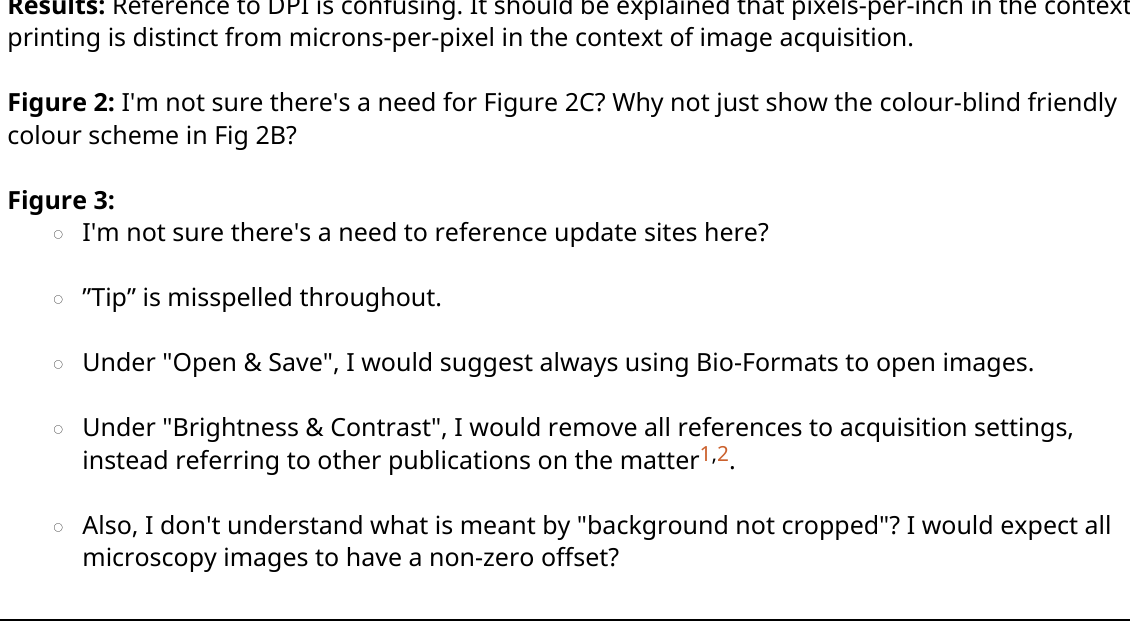
Figure 2: I'm not sure there's a need for Figure 2C? Why not just show the colour-blind friendly colour scheme in Fig 2B? Figure